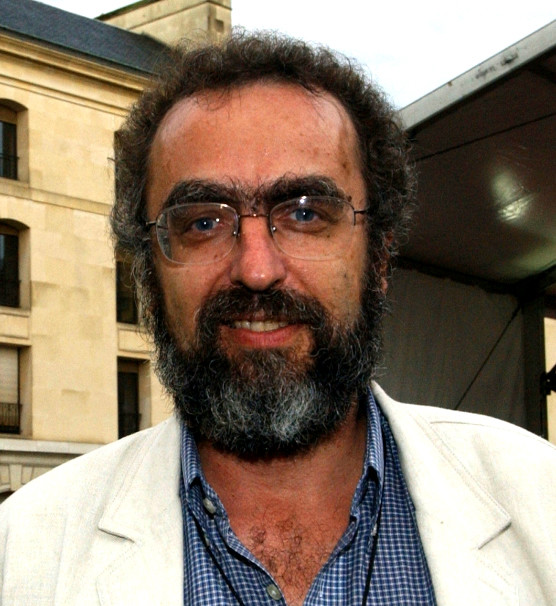
Thierry Heidmann.